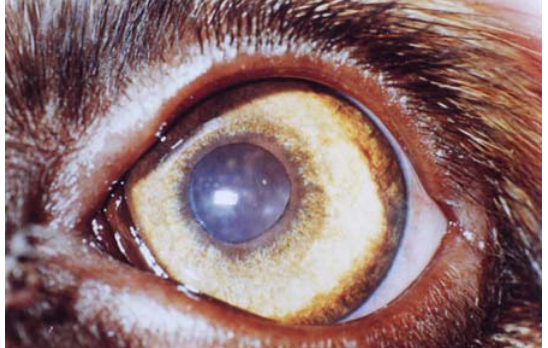
Figure 6. Detail of a dog cornea 30 days after application of the fibrin adhesive derived from snake venom in an animal of Group 5. A good recovery of clearness was observed, indicating that the repair process keeps active, promoting the organization of the corneal stroma and the visual rehabilitation of the